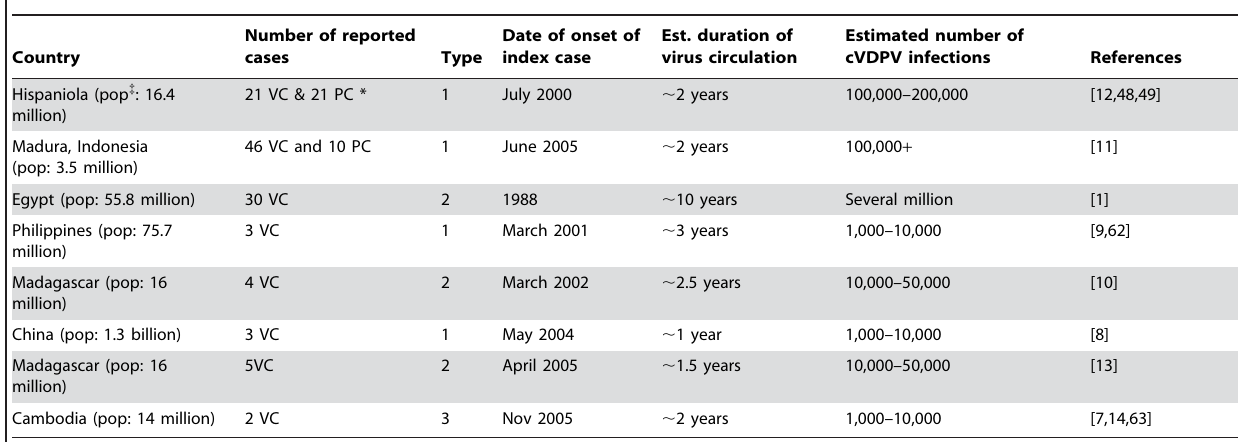
Table 1. Summary of reported cVDPV outbreaks with corresponding estimated number of infections